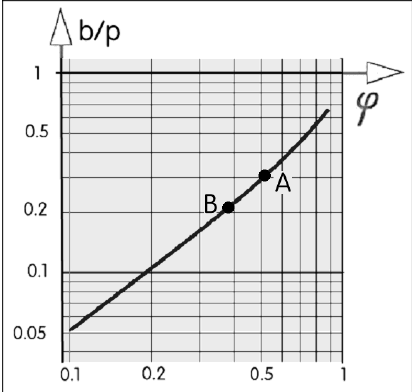
Figure 5. Dependence between the channel area density (defined in Figure 2) and the relative thickness b/p of channel walls. Points A and B represent the matrix samples used in the discussed experiments.